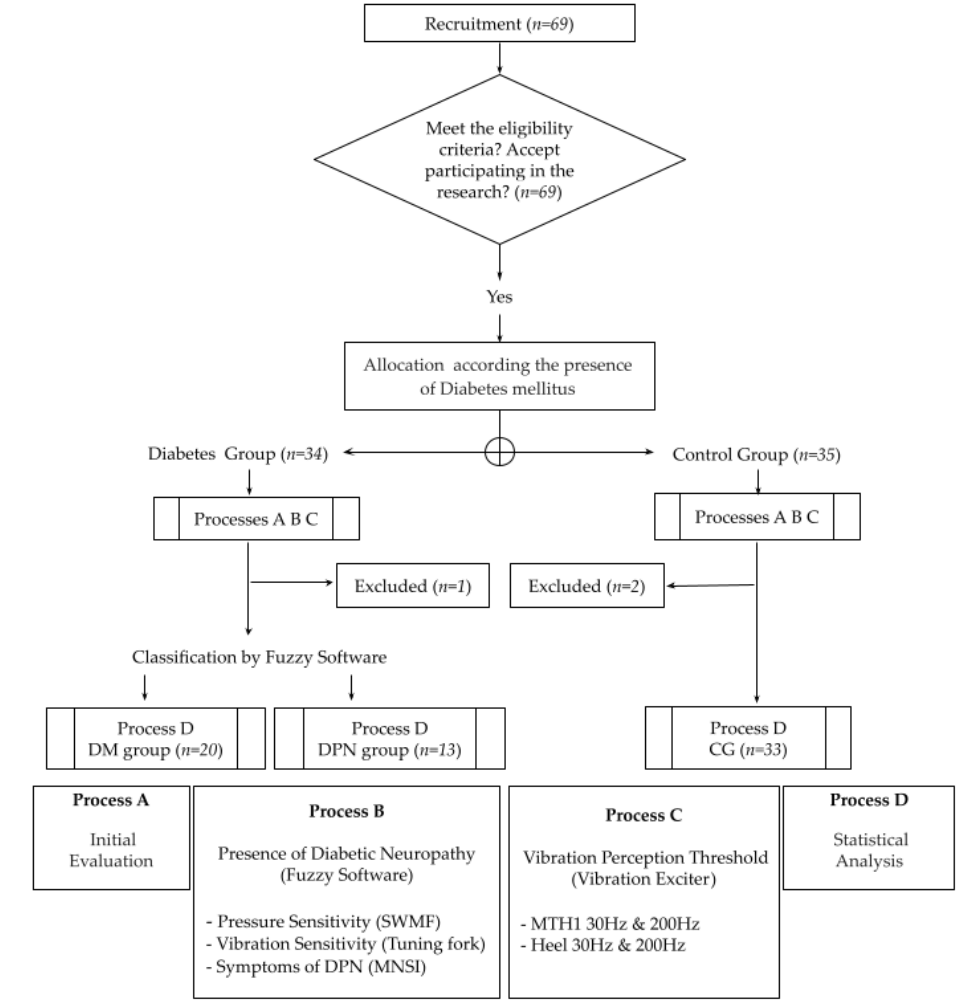
Figure 1. The measurement procedures included three processes: (A) Initial evaluation to check the eligibility criteria, (B) detection and classification of DPN, and (C) evaluation of vibration sensitivity. Statistical evaluation was performed as process D. SWMF, Semmes Weinstein Monofilaments; MNSI, Michigan Neuropathy Screening Instrument; VPT, Vibration Perception Threshold; DM group, participants with diabetes; DPN group, participants with diabetes and diabetic neuropathy; CG, control group; MTH1, first metatarsal head.